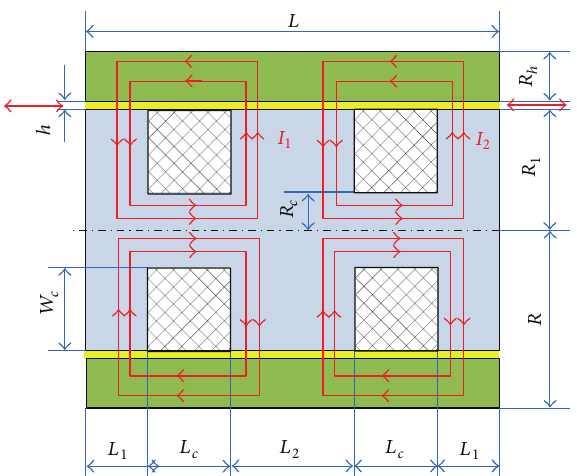
Figure 2: Simplified magnetic circuit of the double coil MR damper.